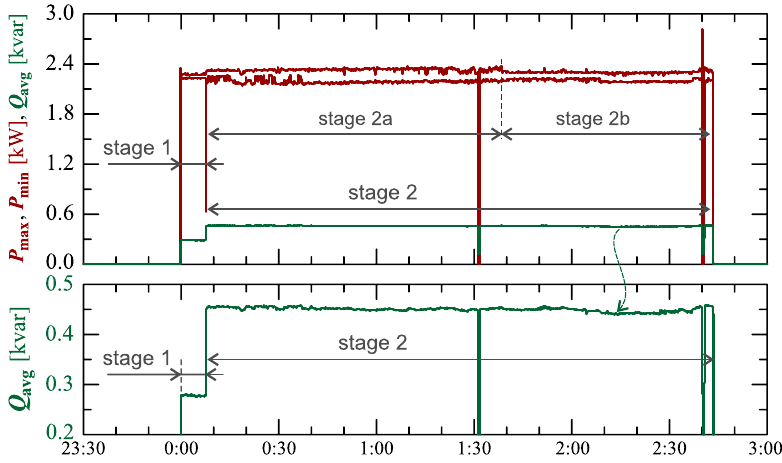
Figure 15. The characteristics of the maximum P max = f ( t ) and minimum P min = f ( t ) values of active power and average values of reactive power Q agv = f ( t ) for Case II.